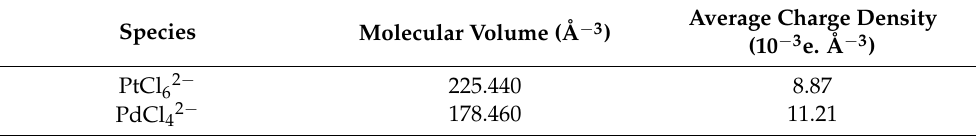
Table 8. The data of metal chloride anion (at B3LYP/6-31G**/SDD level).